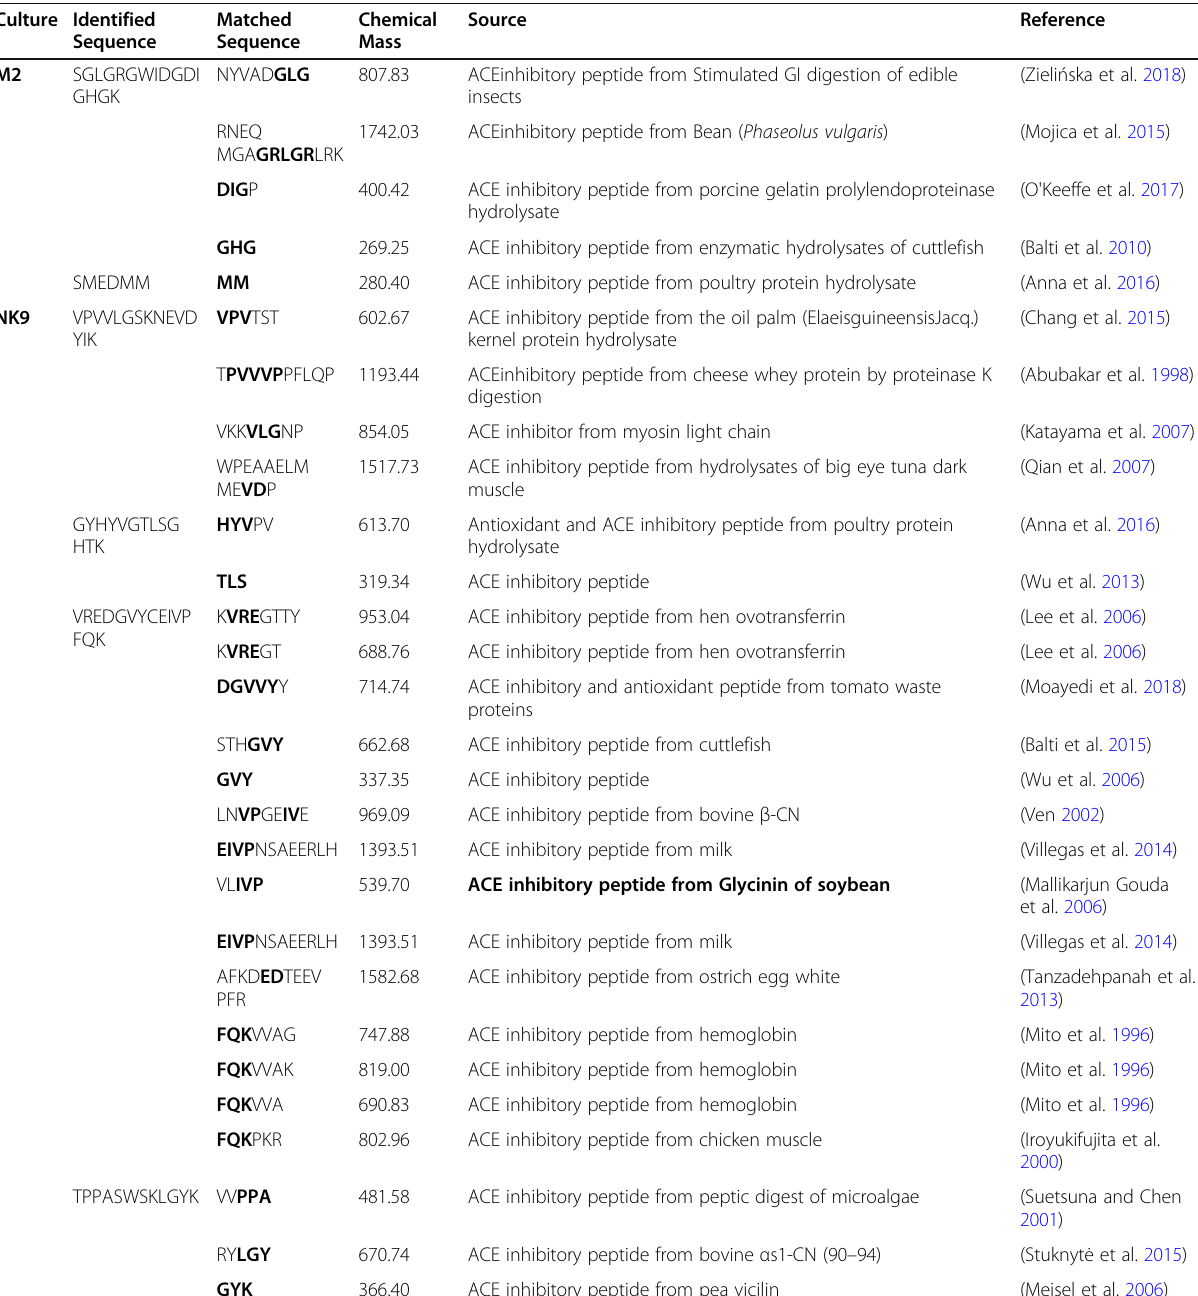
Table 5 List of ACE inhibitory peptides (3 kDa permeate) by Biopep software Culture Identified Matched Chemical Source Sequence Sequence Mass